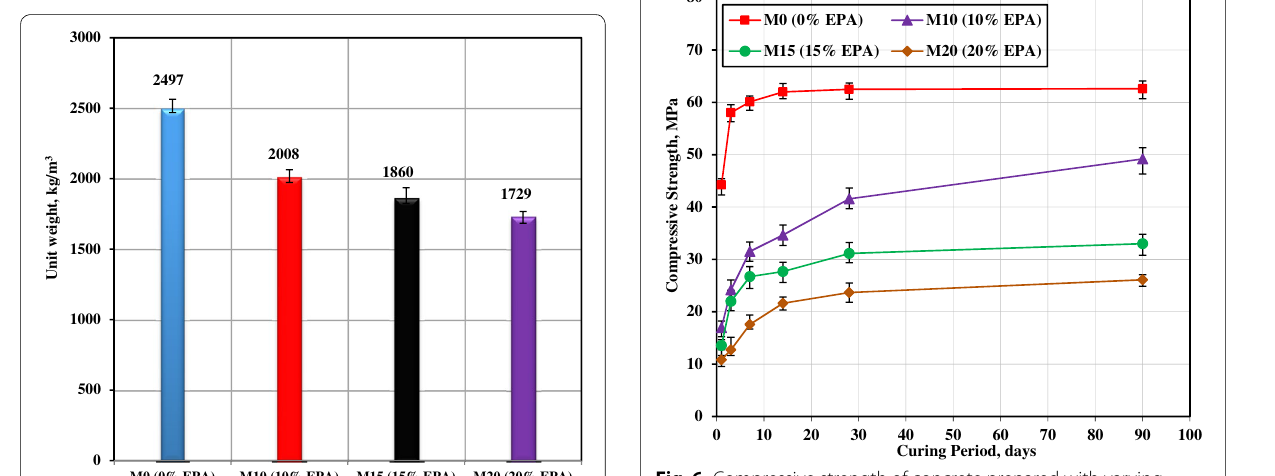
Fig. 6 Compressive strength of concrete prepared with varying quantity of